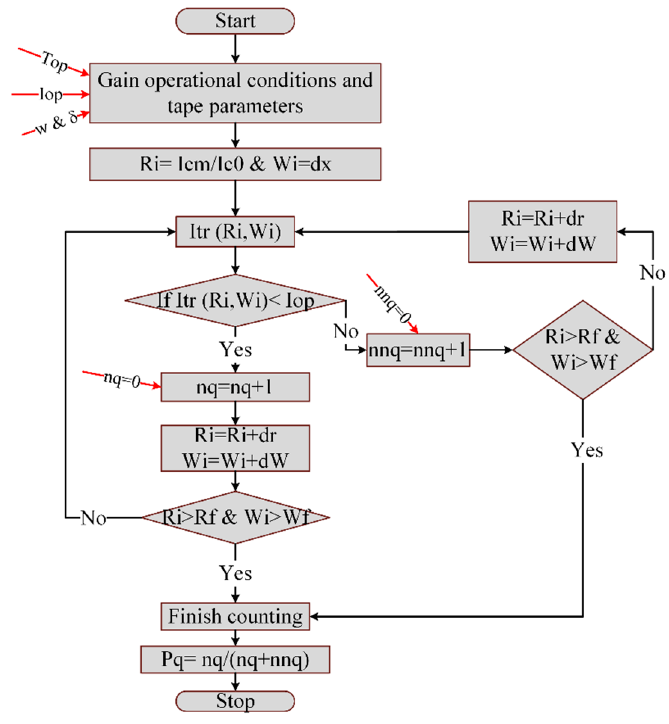
Figure 3. The flowchart of the proposed model to calculate the probability of quenches.